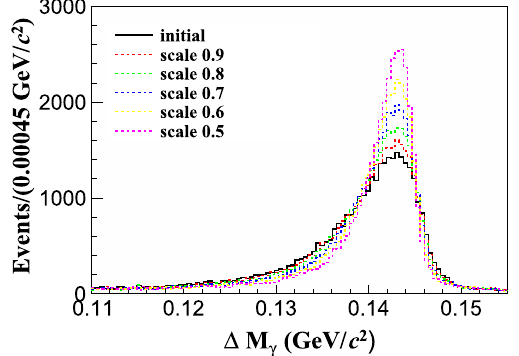
Fig. 6 The (cid:13) M optimization with γ energy resolution. Scale is the optimized proportion of the initial values of detector of response